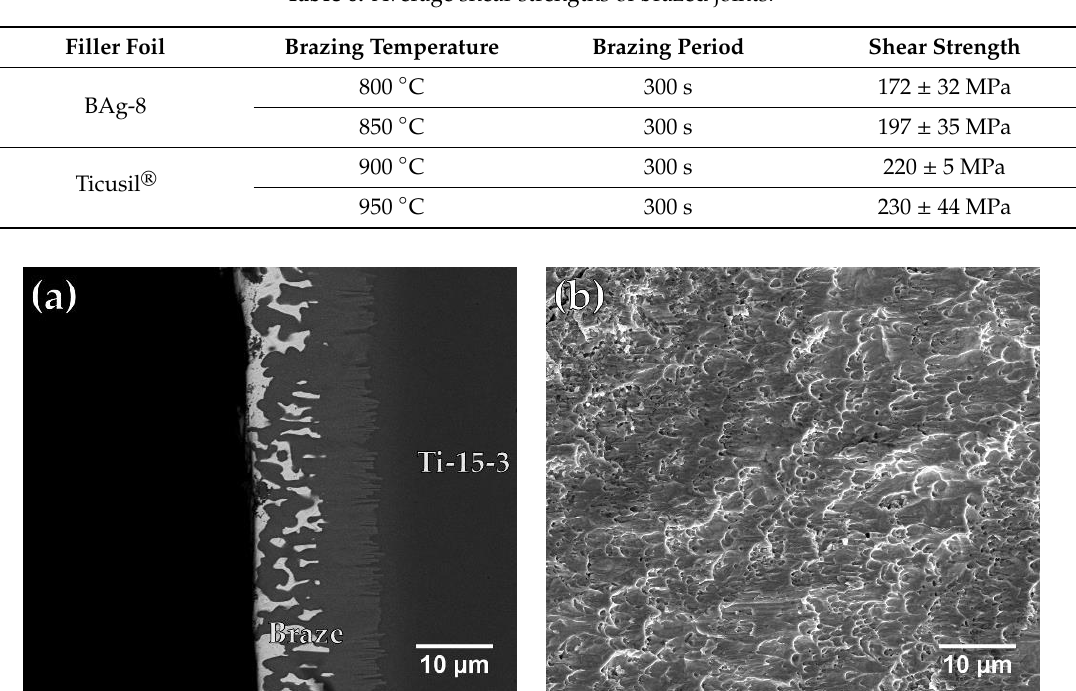
Figure 8. FESEM ( a ) BEI cross section and ( b ) SEI fractograph of Ti-15-3/BAg-8/Ti 50 Ni 50 joint brazed at 850 °C for 300 s after shear test.